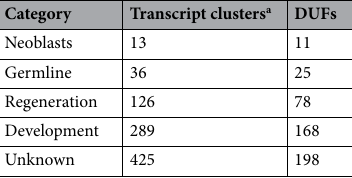
Table 1. Categories of DUF genes in M. lignano. a Same transcript cluster can belong to several categories.